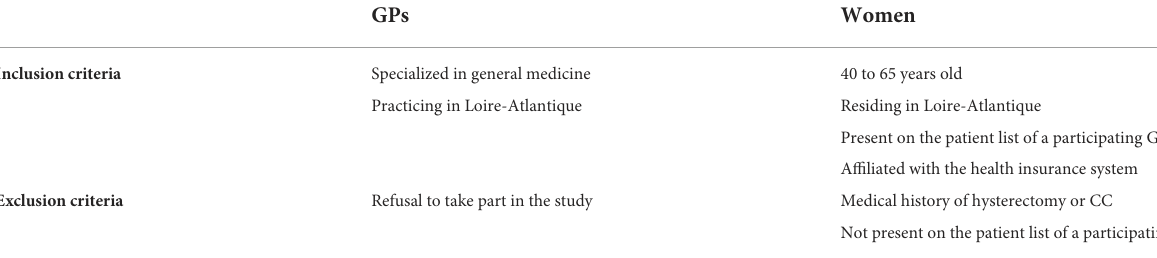
TABLE 1 Inclusion and exclusion criteria for GPs and